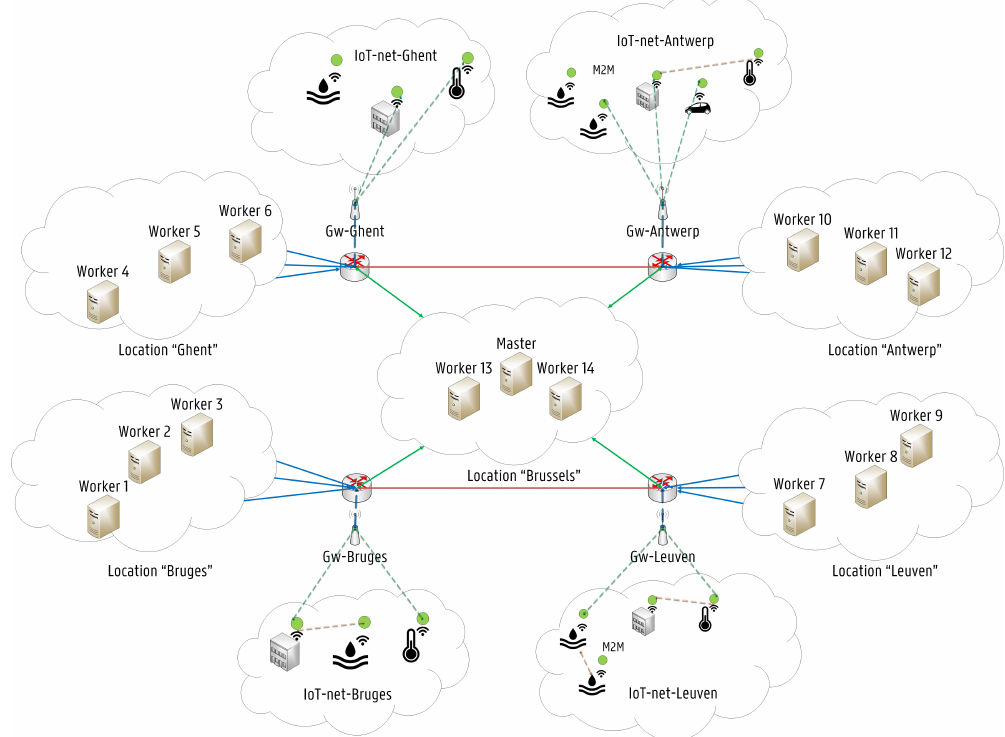
Figure 2. High-level view of the proposed Fog Computing infrastructure based on the Kubernetes